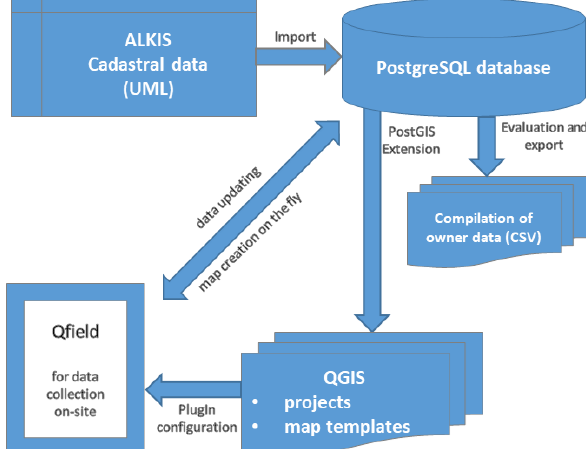
Figure 2: Workflow for the processing of the ALKIS data to support urban development